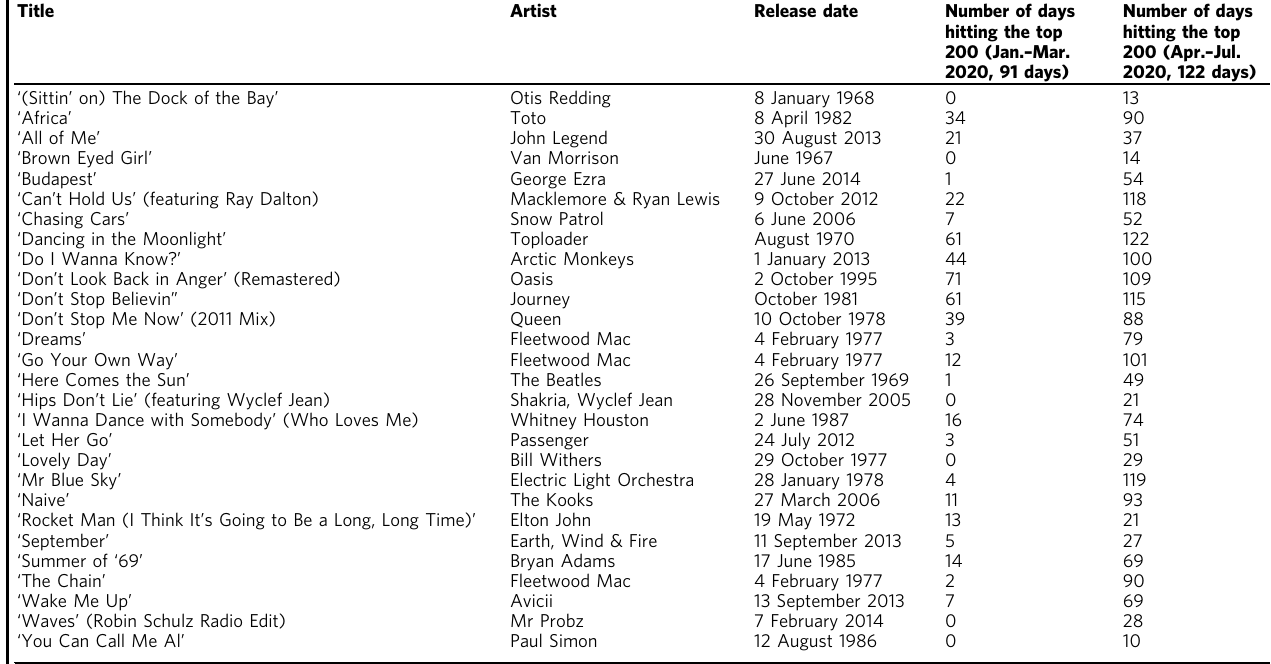
Table 2 List and details of the 28 revived songs.